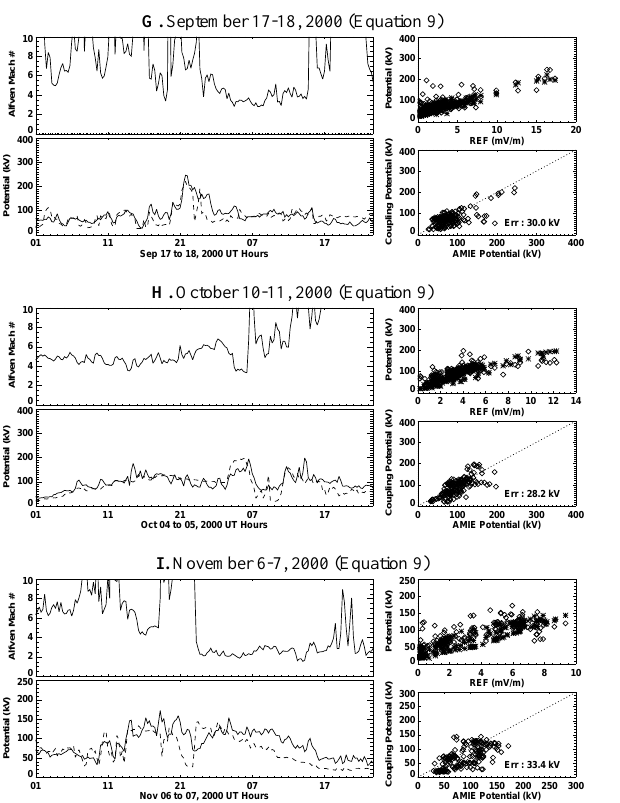
Fig. 13. The same three events in Fig. 3, plotted in the same way as Fig. 11.